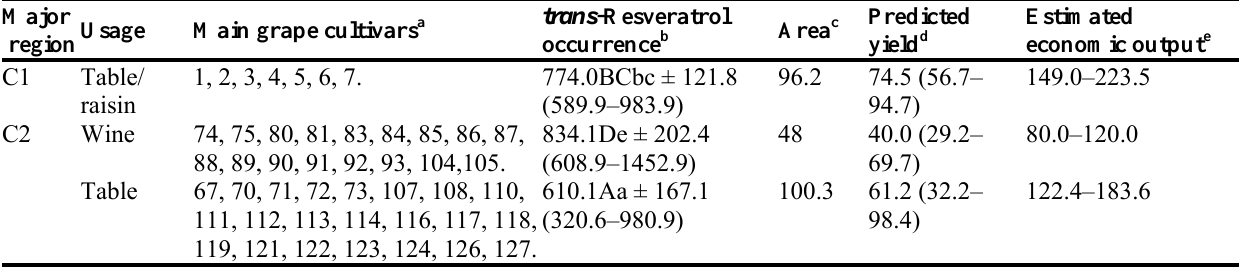
Table 3. Occurrence and potential value estimation of trans -resveratrol in main grape cultivars from seven major grape production